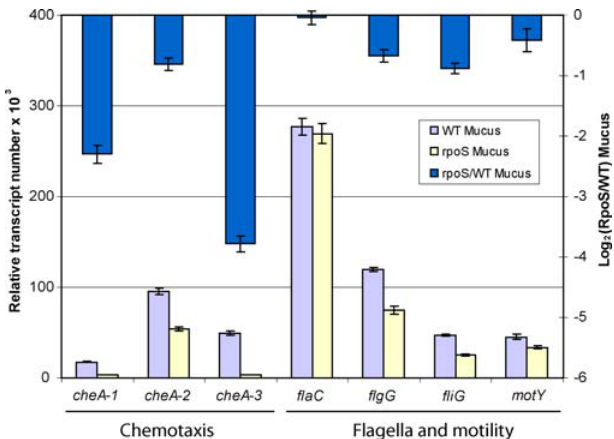
Figure 4. RpoS Is Required for the Expression of Chemotaxis and Motility Genes in Rabbit Ileal Loop Mucus Real-time RT-PCR was used to assess relative gene expression of selected motility genes in the wild-type parent or the rpoS mutant isolated from rabbit ileal loop mucus 12 h post-inoculation for selected genes involved in chemotaxis and flagellar biosynthesis. The left vertical axis depicts the relative transcript number ( 3 10 3 ) for the wild-type parent (light blue) and the rpoS mutant (yellow). The right vertical axis depicts the Log 2 to the ratio of transcript abundance for the rpoS mutant and the wild-type parent (dark blue). Data from one typical experiment are